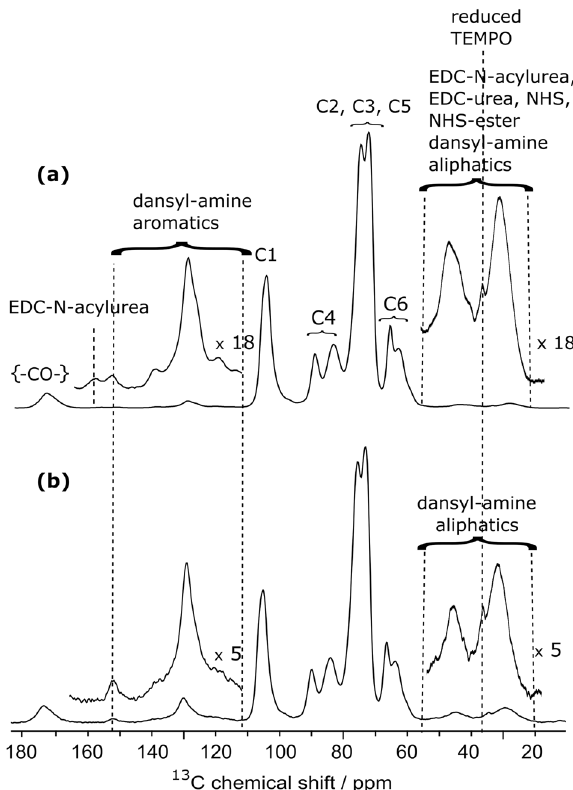
Fig. 2 DNP-enhanced 13C NMR of surface-functionalized CNF. DNP- enhanced { 1 H}- 1 3 C CPMAS NMR spectra of surface-functionalized CNF with 6-aminohexyl dansyl-amide using a EDC and NHS and b DMTMM as coupling agent. The 13 C resonance assignment for ( a ) and ( b ) is given in the fi gure. The insets in ( a ) and ( b ) show magni fi ed views of the 20 – 55 ppm and 115 – 165 ppm regions. Both spectra were normalized with respect to the cellulose signal intensities. Magni fi cation factors for the insets, ×18 for ( a ) and ×5 for ( b ), were chosen in order to match the signal intensity for the aromatic dansyl-amine